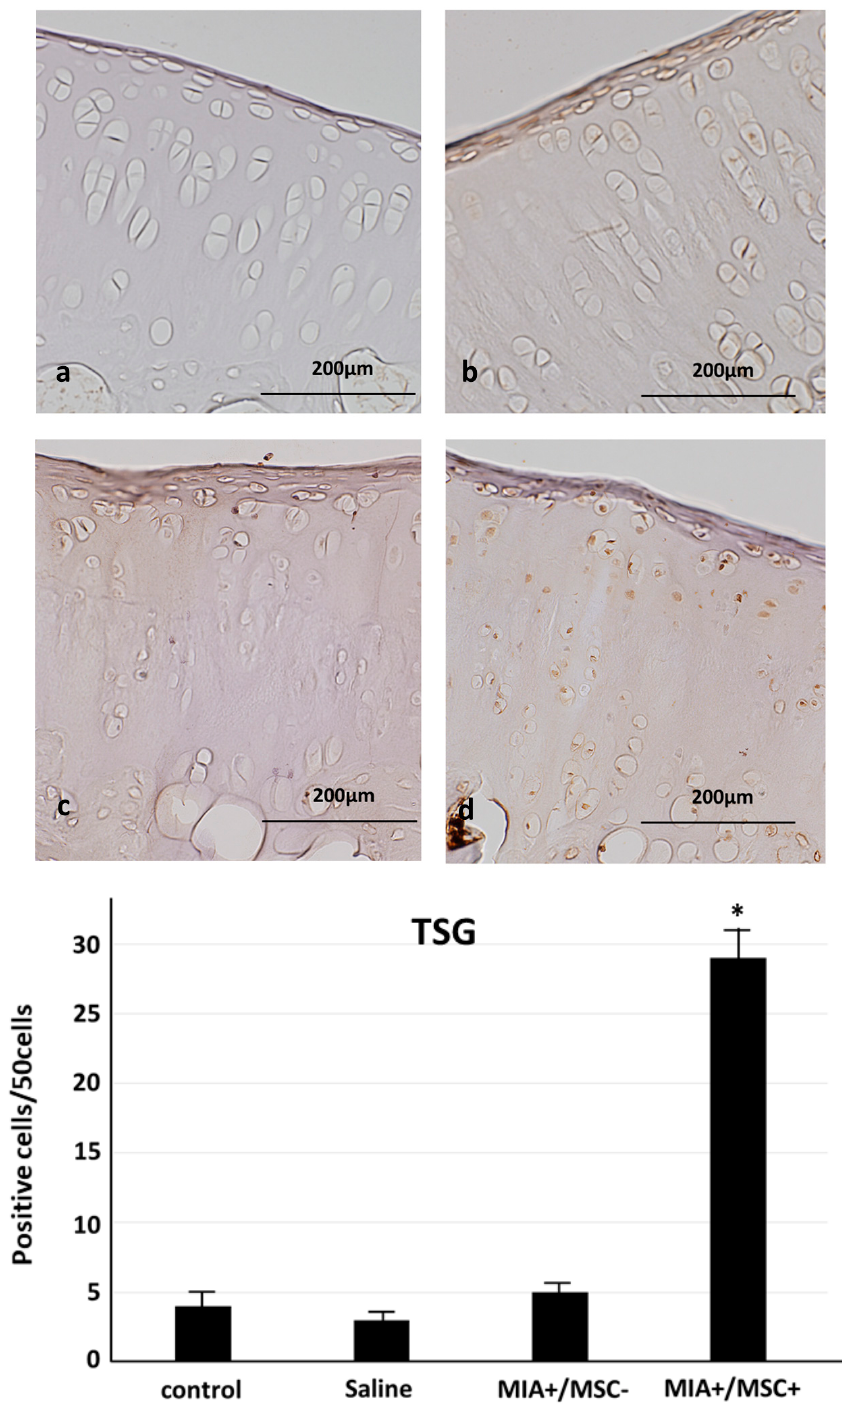
Figure 3. TNF- α stimulated gene/protein 6 (TSG-6) expression in cartilage tissue. ( a ) control group, ( b ) Saline group, ( c ) MIA+/MSC − group, ( d ) MIA+/MSC+ group. Control group and Saline group: Almost no TSG-6 expression is found in cartilage tissue. MIA+/MSC − group: Like in A, TSG-6 is not found anywhere in cartilage tissue. MIA+/MSC+ group: TSG-6 expression is found extensively from the surface layer to deep layer of cartilage tissue. As compared with control, Saline, MIA+/MSC − group, a significant increase in TSG-6 expression is found only in the group administered with MSC. * p < 0.01 compared to the MIA+/MSC − group.